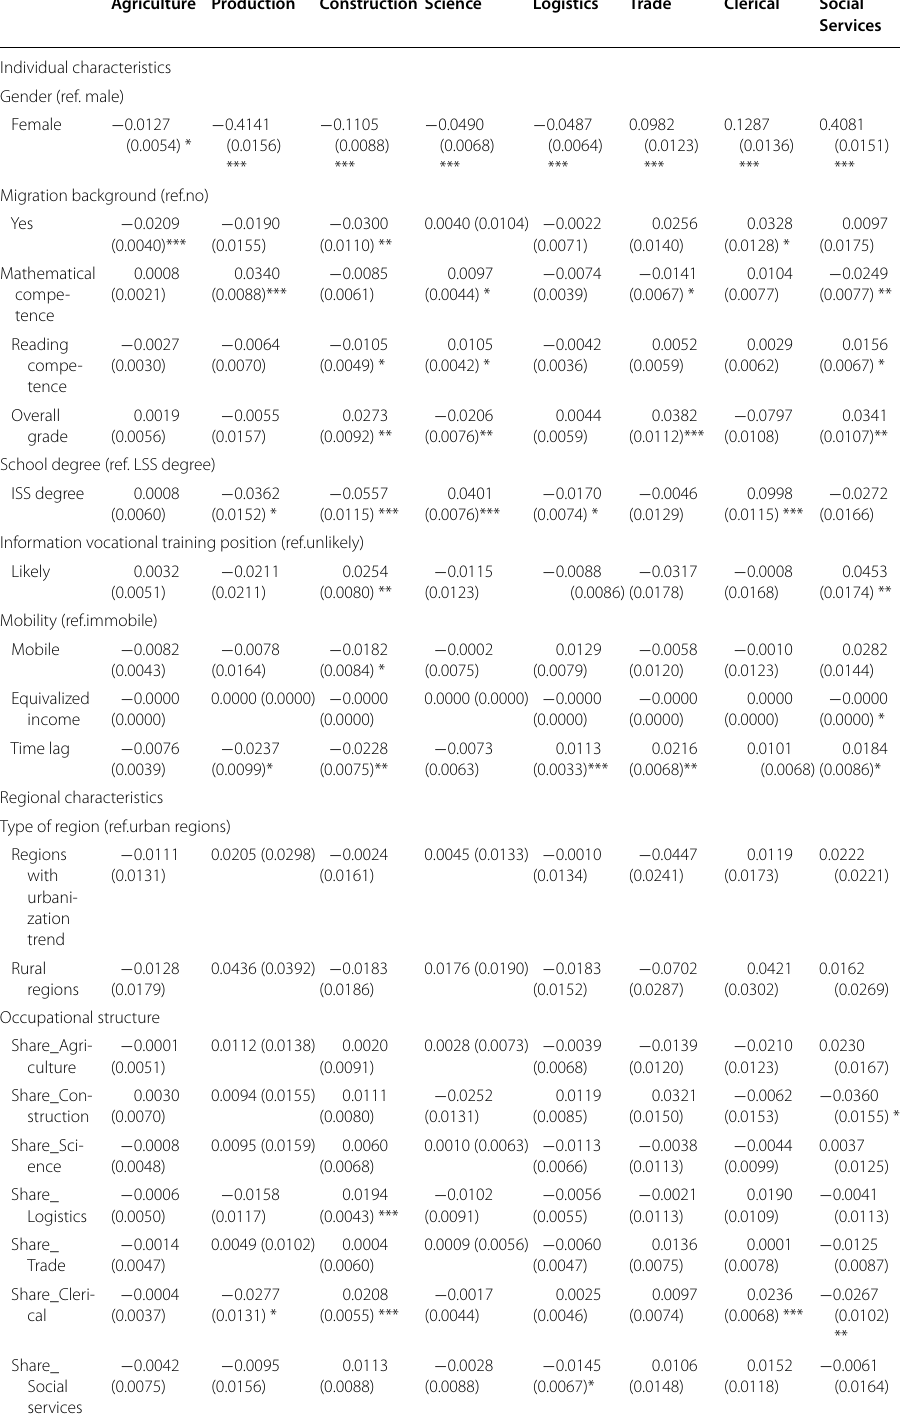
Table 5 Multinomial logit full-sample model without preferences (AME) Agriculture Production Construction Science Logistics Trade Clerical Social